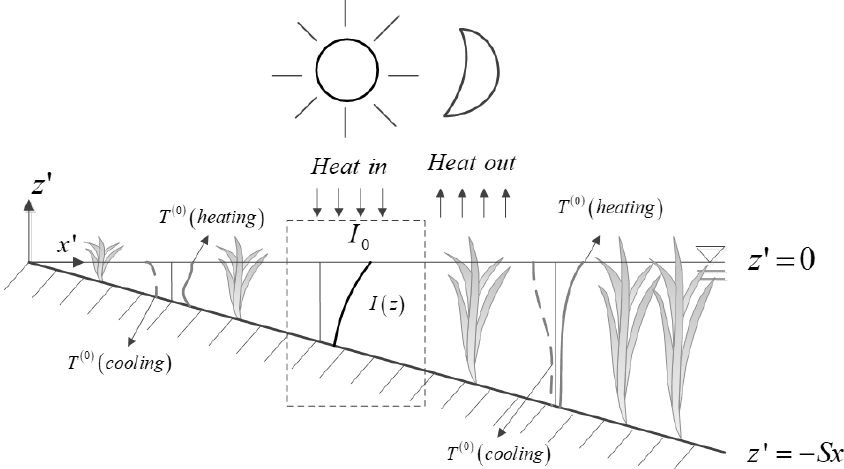
Figure 1. Geometry of the flow domain showing the coordinate system and different heating and cooling mechanisms. cooling